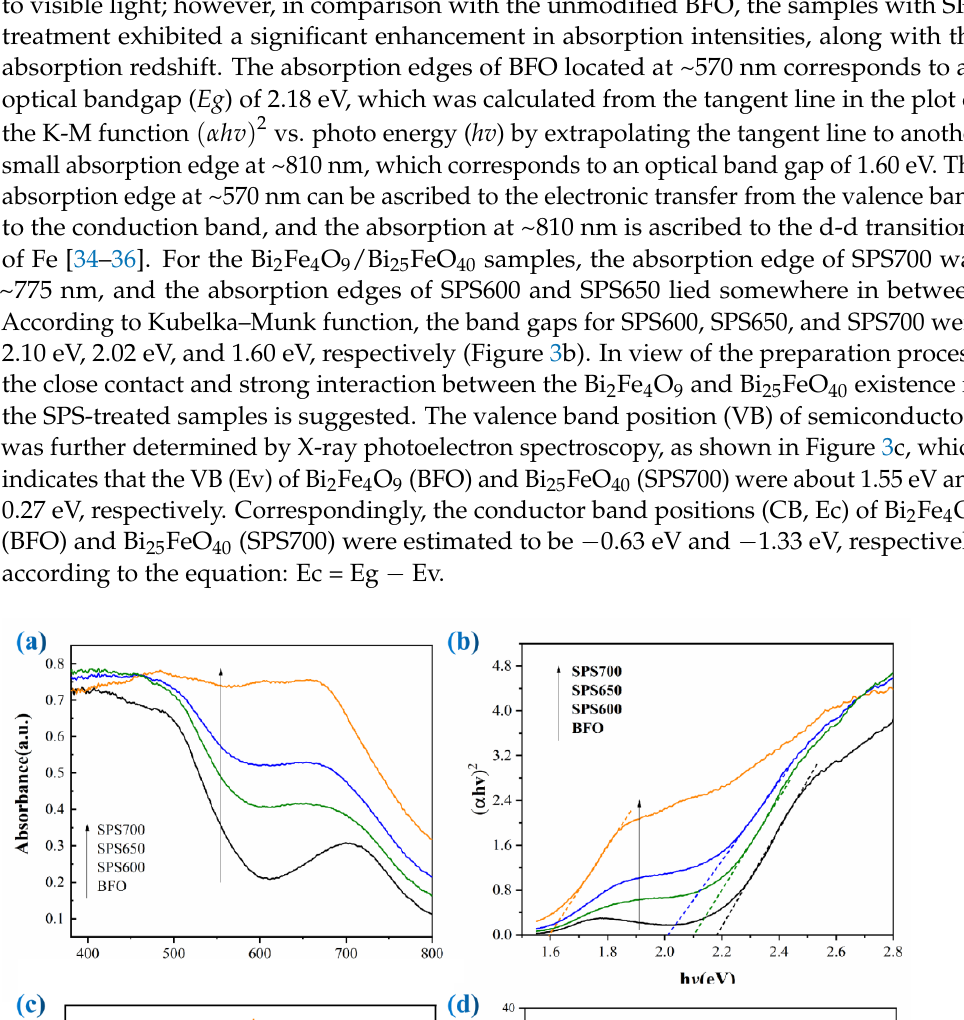
Figure 2. HRTEM image of ( a ) untreated BFO, ( b ) SPS650, ( c , d ) corresponding magnified image of